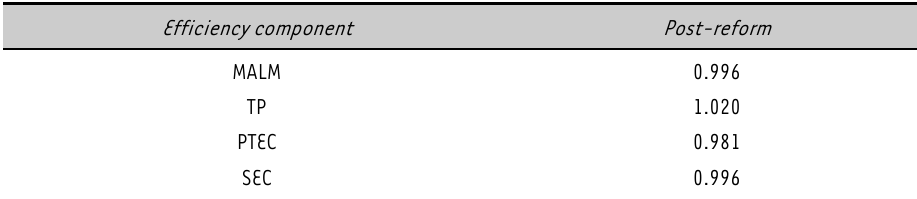
DEA Results: (Geometric) Average annual measures of TFP change and